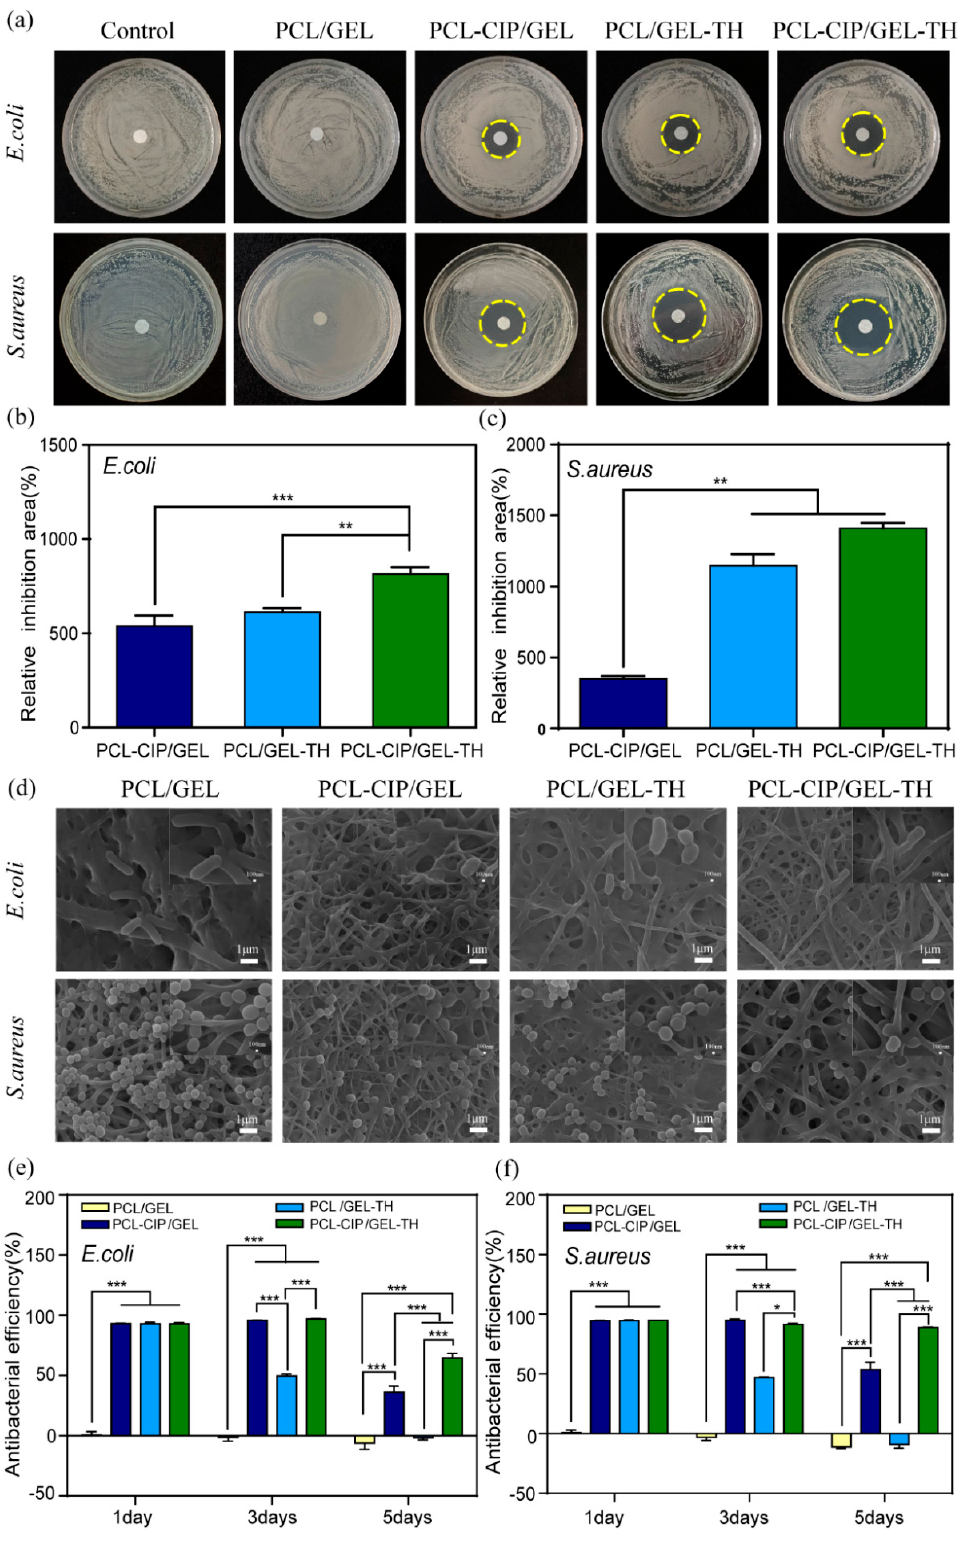
Figure 5. Antibacterial activity of coaxial nanofibers against E. coli and S. aureus . ( a ) Inhibition zone assay; ( b , c ) bar diagrams of antibacterial efficacy of different membranes ( n = 3); ( d ) SEM images of the morphologies of E. coli and S. aureus on different nanofibers; ( e , f ) the long-lasting antibacterial effects evaluation of different nanofibers by CCK-8 assay ( n = 3). *— p < 0.05; **— p < 0.01; ***— p < 0.001.